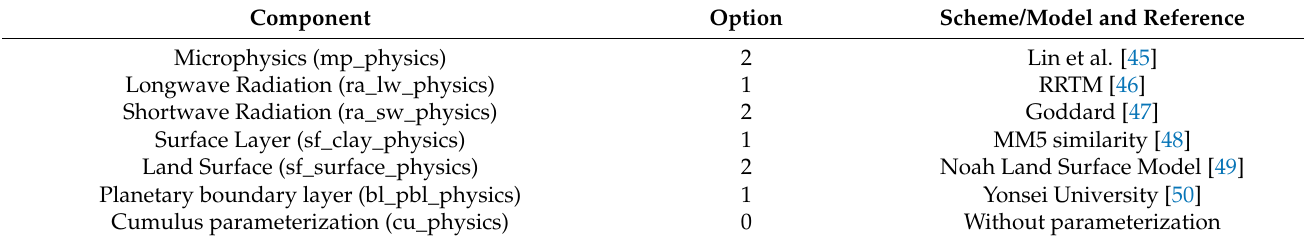
Table 1. Options for modeling the dispersion of PM 2.5 in Cuenca (WRF-Chem 3.2). Component